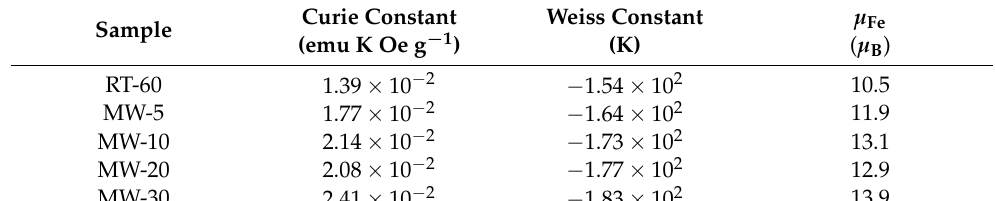
Table 6. Fitted parameters of Curie–Weiss law.